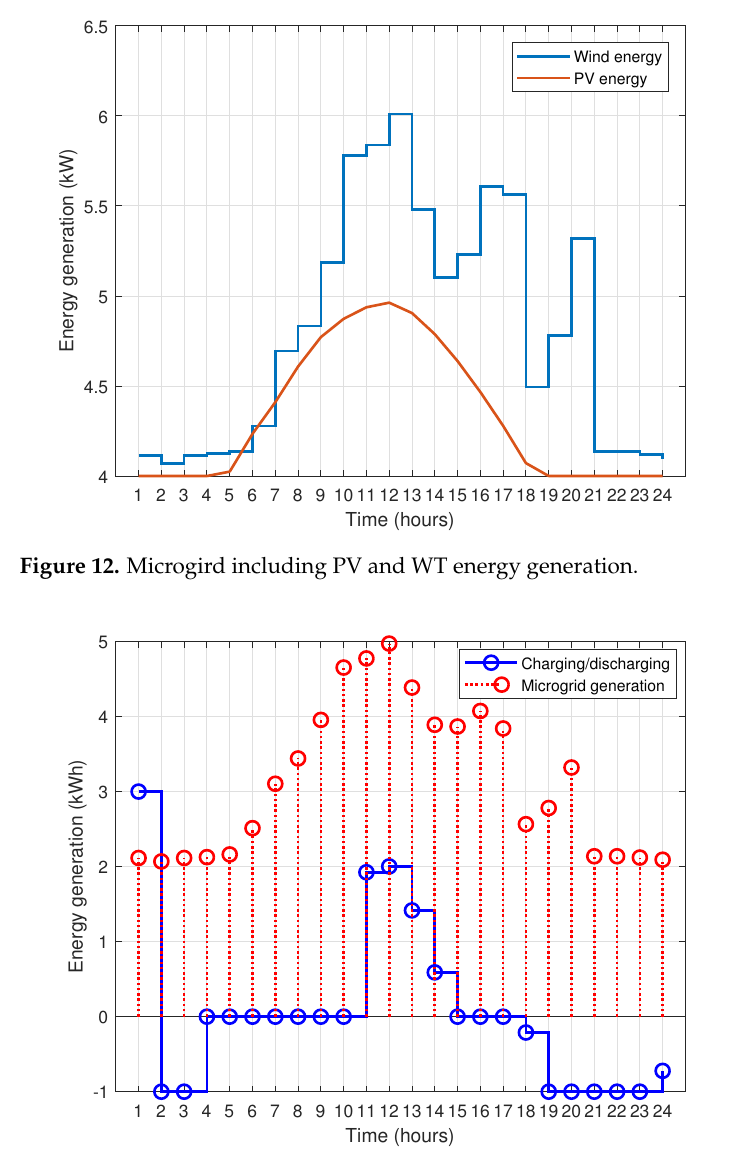
Figure 13. Charging/discharging behavior of EVs with microgrid generation. The contribution of EVs and ESSs in serving the load is depicted in Figure 14. The por- tion of the load that is served (operated) with EVs and ESSs results in low carbon emission, energy cost, and PAR compared to the portion which utility companies serve. Thus, when EVs and ESSs have significant charging, then there is no need for the consumers to import electricity in the following conditions: during peak hours, and when renewable generation is minimum. EVs and ESSs will serve the load to reduce carbon emission, energy cost, and PAR during such a